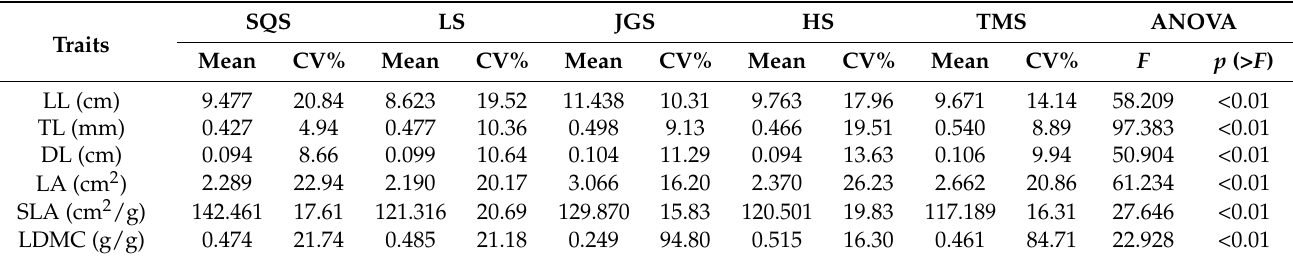
Table 3. Mean values, coefficients of variance (CV%), and analysis of variance of needle traits in P. hwangshanensis . The population abbreviations are the same as in Table 1. Numbers in bold symbolize statistical significance.